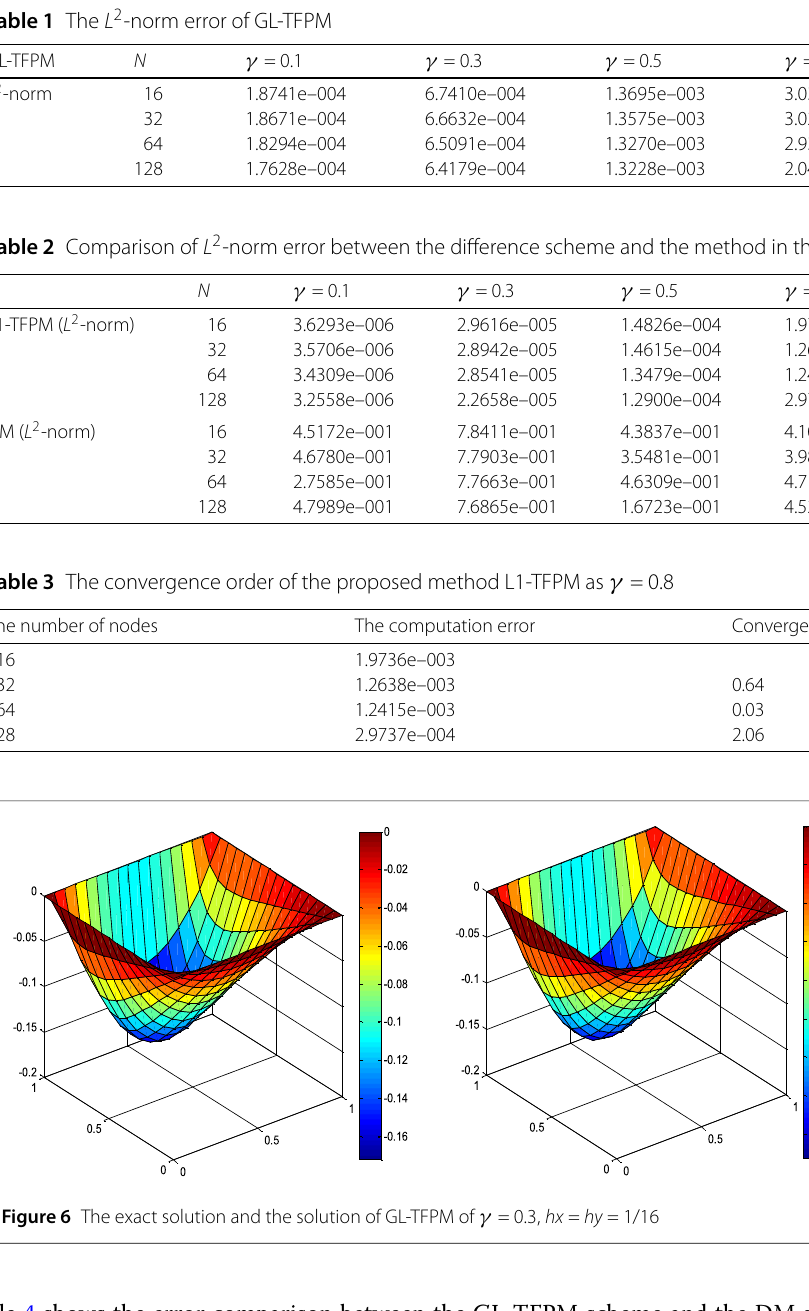
ble 4 shows the error comparison between the GL-TFPM scheme and the DM